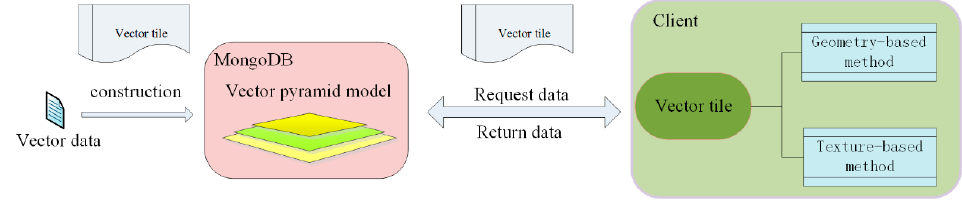
Figure 5. The construction and 3D visualization for the VTPM.